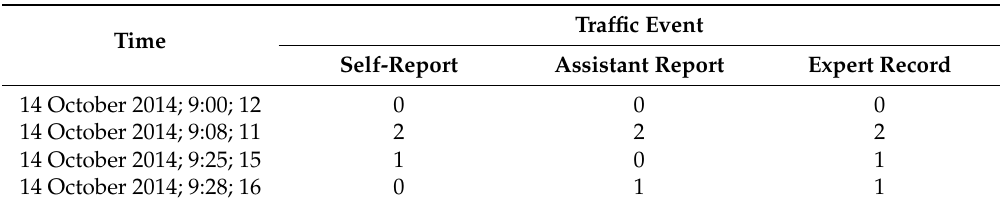
Table 2. A sample of the traffic event record.